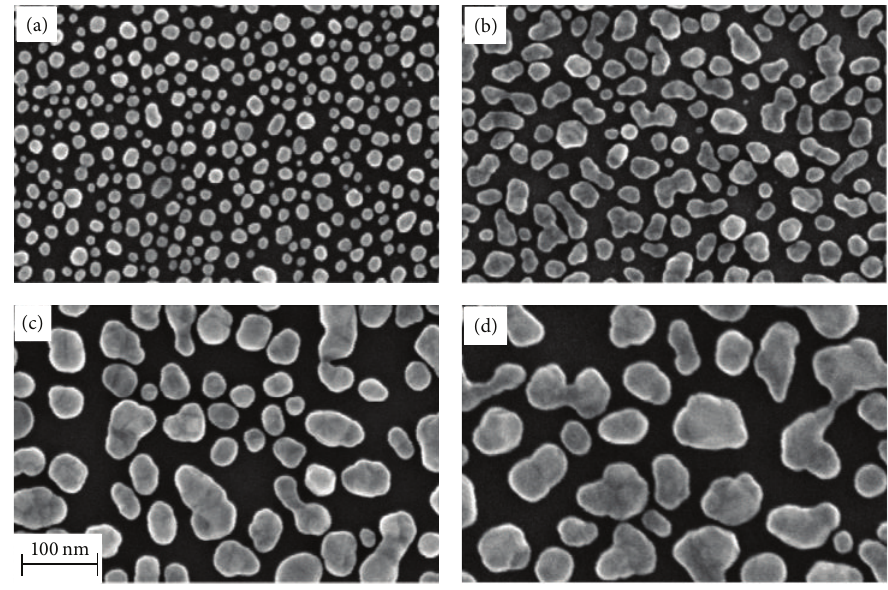
Figure 3: SEM images of Ag films directly deposited on a dielectric substrate. The film thickness is 4, 5.5, 10, and 12nm in (a), (b), (c), and (d),